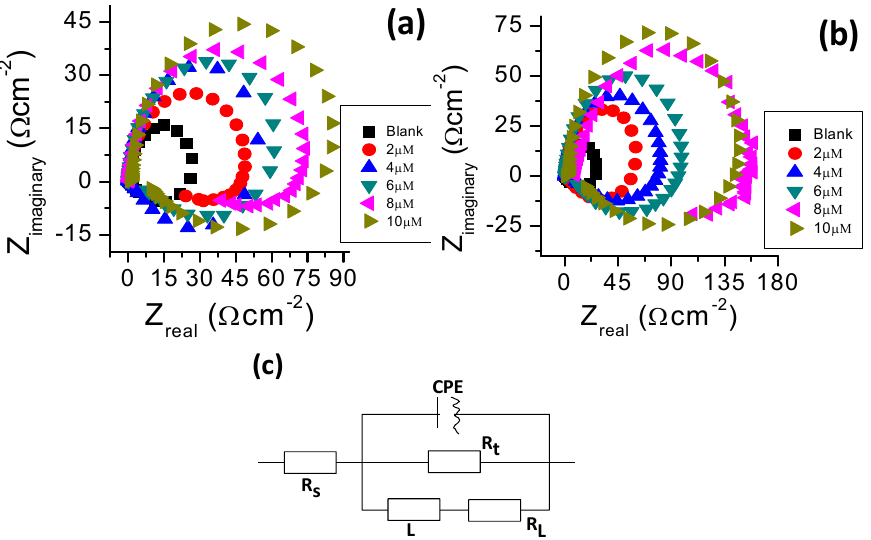
Figure 7. Nyquist plots of aluminium in 1.0 M hydrochloric acid solution with BTThio ( a ) with ClGaBTThio ( b ) and equivalent circuit used to fit EIS data for ( c ).